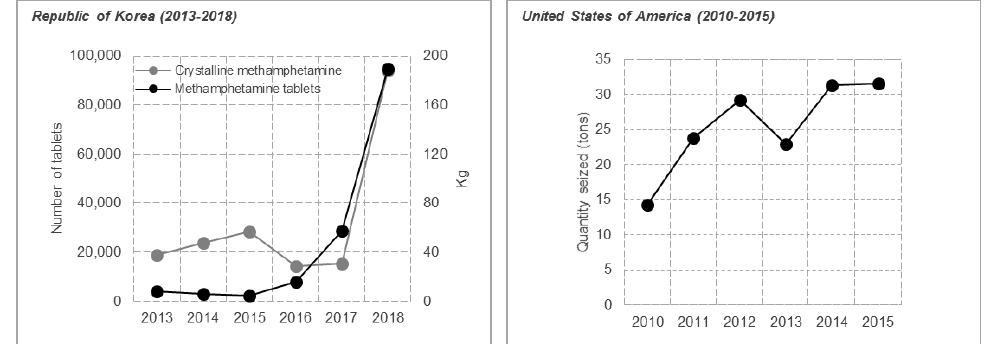
Figure 2. Primary drugs of abuse among persons treated for drug problems in the Republic of Korea (2017) and the United States of America (2016).